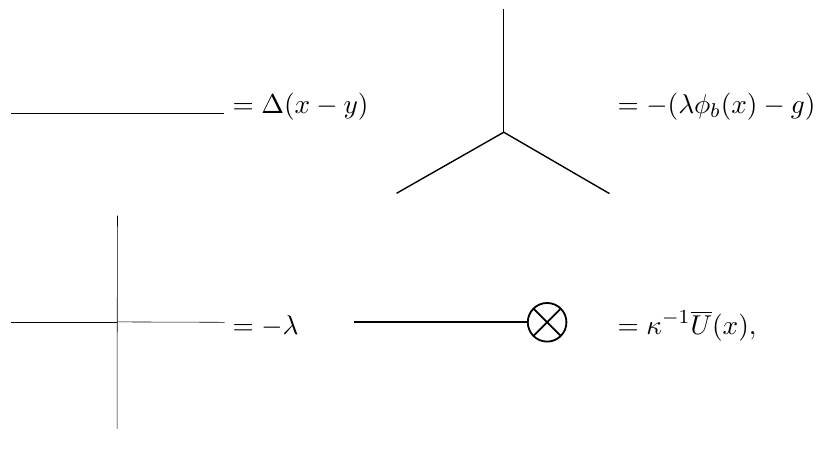
Figure 5 . Feynman rules for a real-scalar